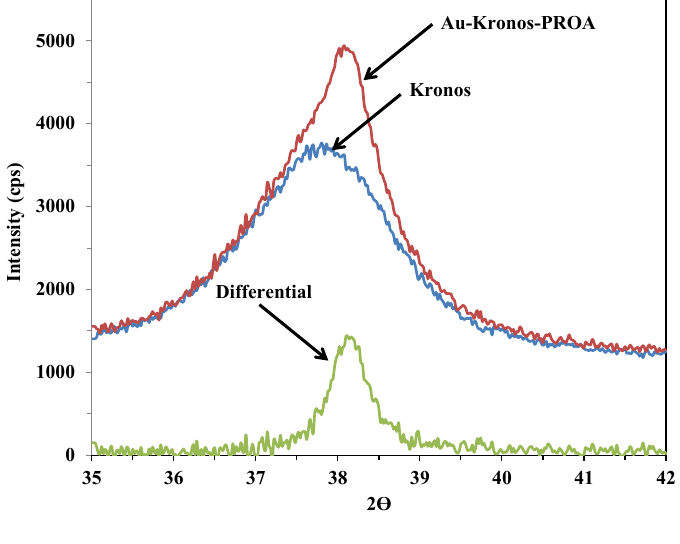
Figure 5. Differential XRD pattern of Au-Kronos-PROA and bare Kronos TiO 2 photocatalysts.